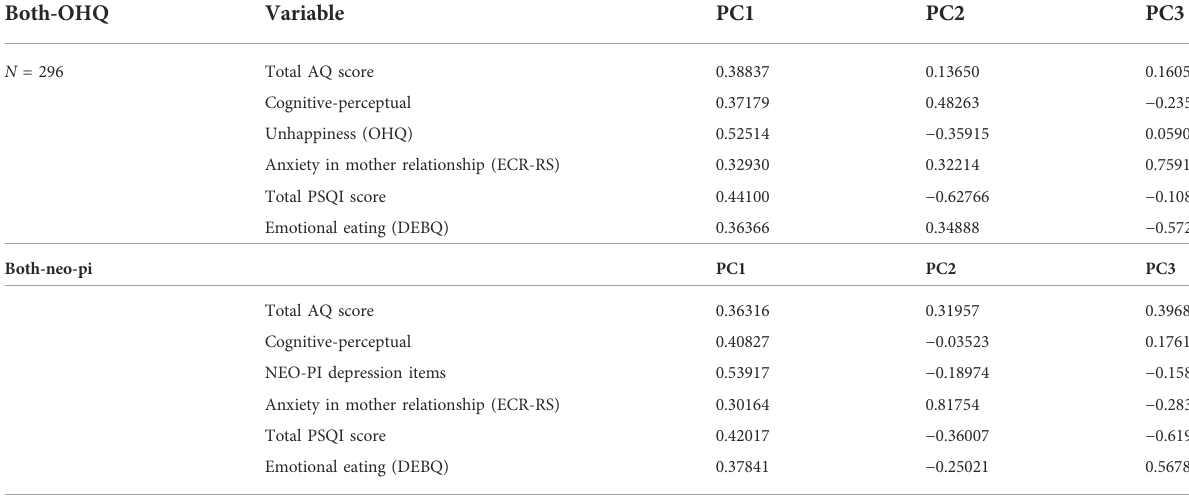
TABLE 4 Loadings for each variable across the three largest principal components in the analyses for the combined population ( N = 296).